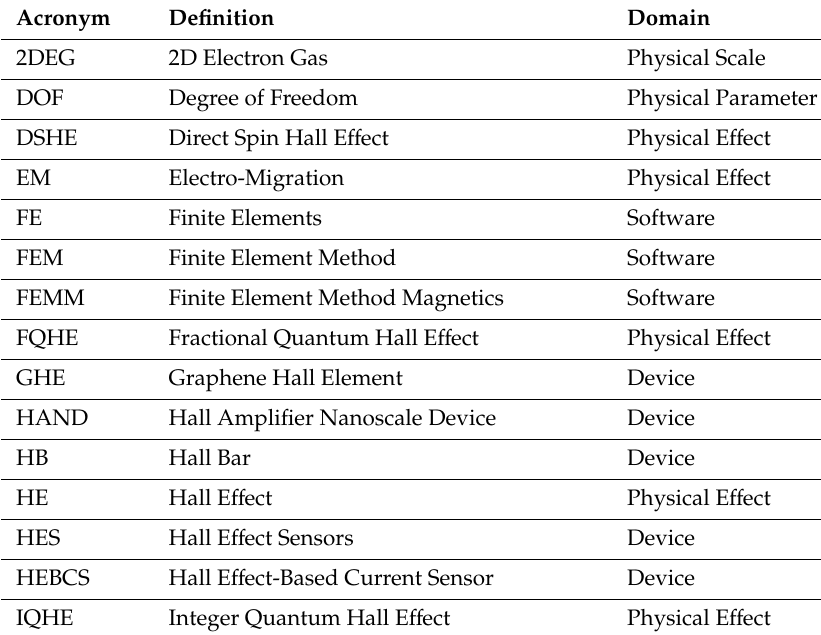
Table A2. Summary table of the Hall E ff ects related